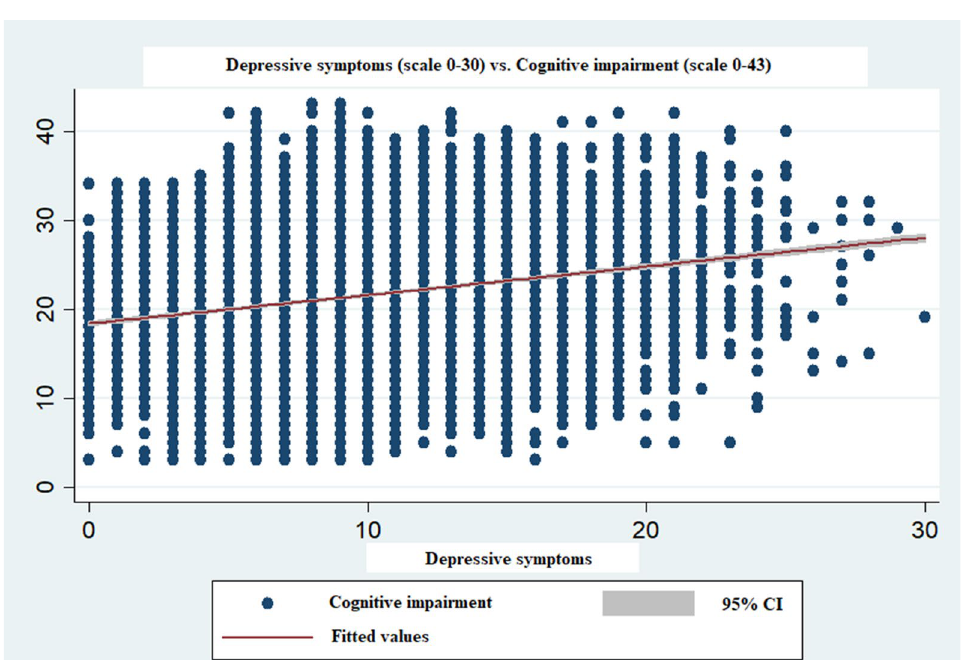
Figure 3. Scatter plot of the significant association ( p < 0.001) between depressive symptoms and cognitive impairment among older adults. Notes Score of CES-D scale ranges from 0 to 30; Composite cognitive impairment scale ranges from 0 to